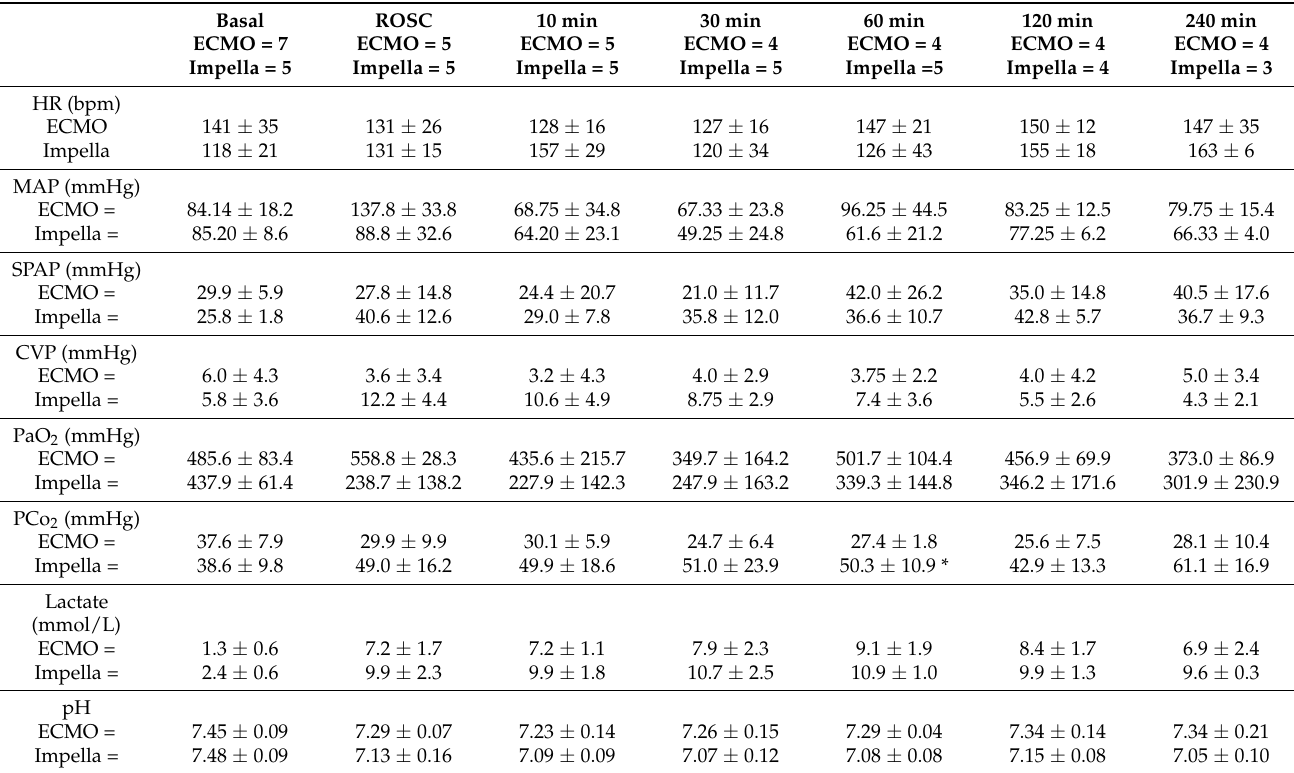
Table 3. Comparison of hemodynamics and blood gas